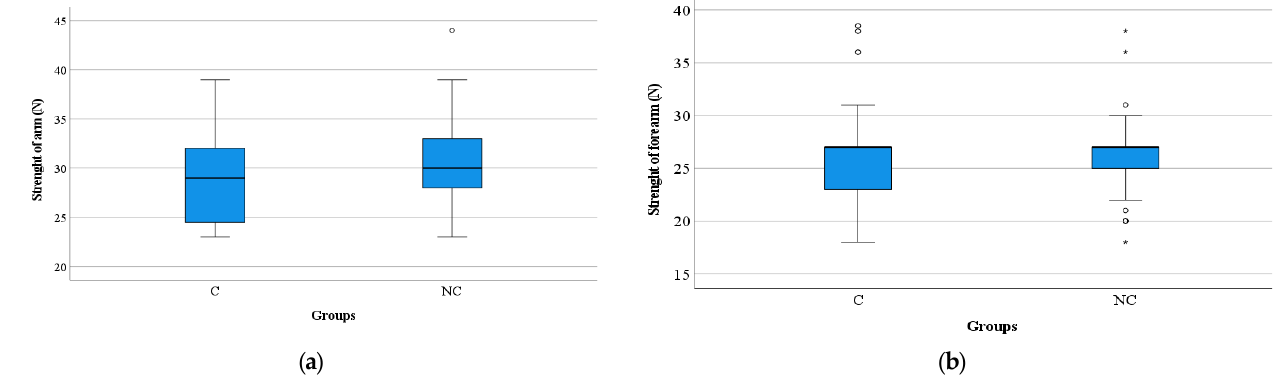
Figure 4. Distribution of muscle strength values in the study groups: ( a ) in arm, ( b ) in forearm. C, COVID-19 patients; NC, non-COVID-19 patients; N, Newton; *, extreme outliers; o, mild outliers. The number of cases that had low arm and forearm strength did not differ statistically significantly between the two groups, according to the patient ’ s gender (Table 5). Table 5. Force ’ s variations according to the patient ’ s gender. Parameter